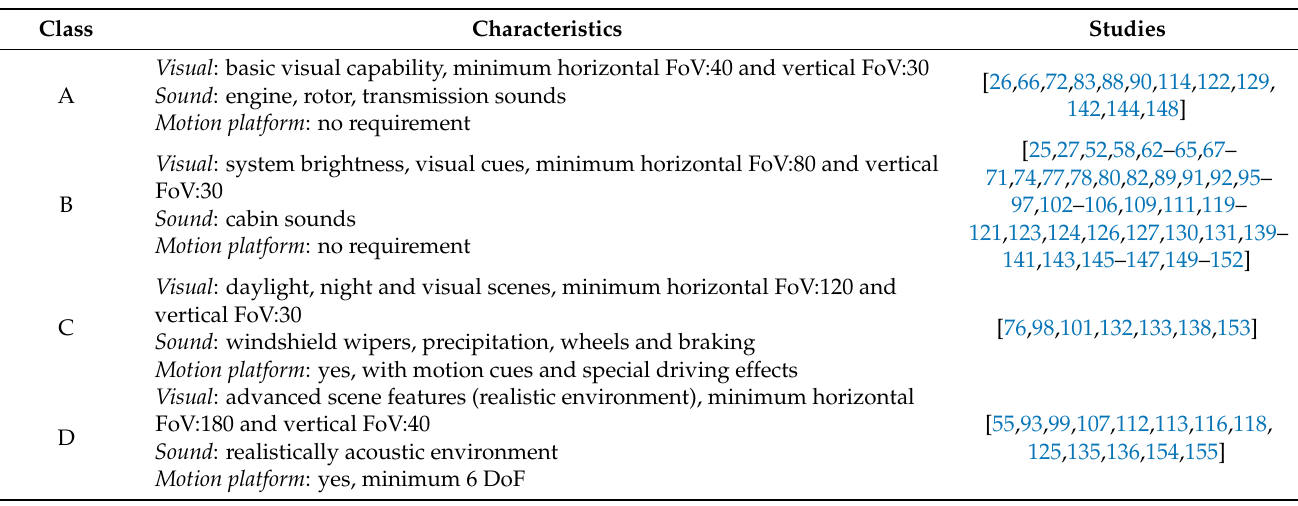
Table 3. Driving simulators classification, according to